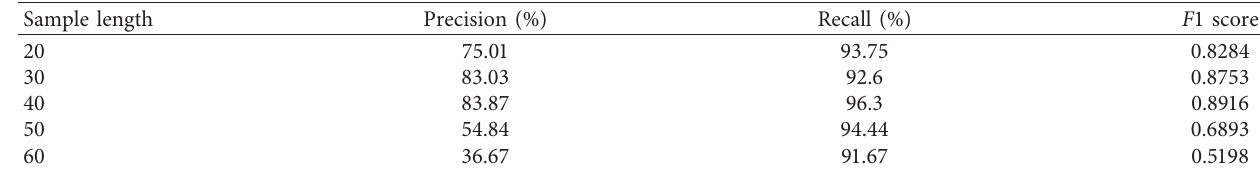
Figure 9: Schematic diagram of generating samples with different iteration numbers. Table 6: Detection results for different sample length.